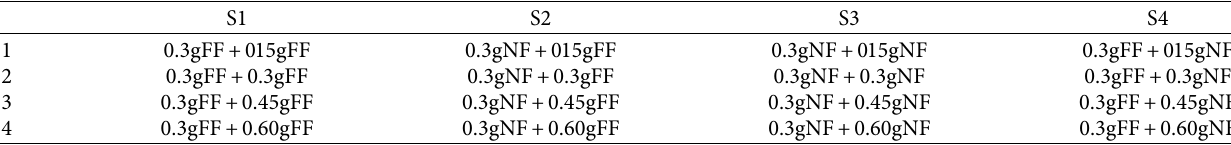
Table 24: Diferent scenarios of sequence